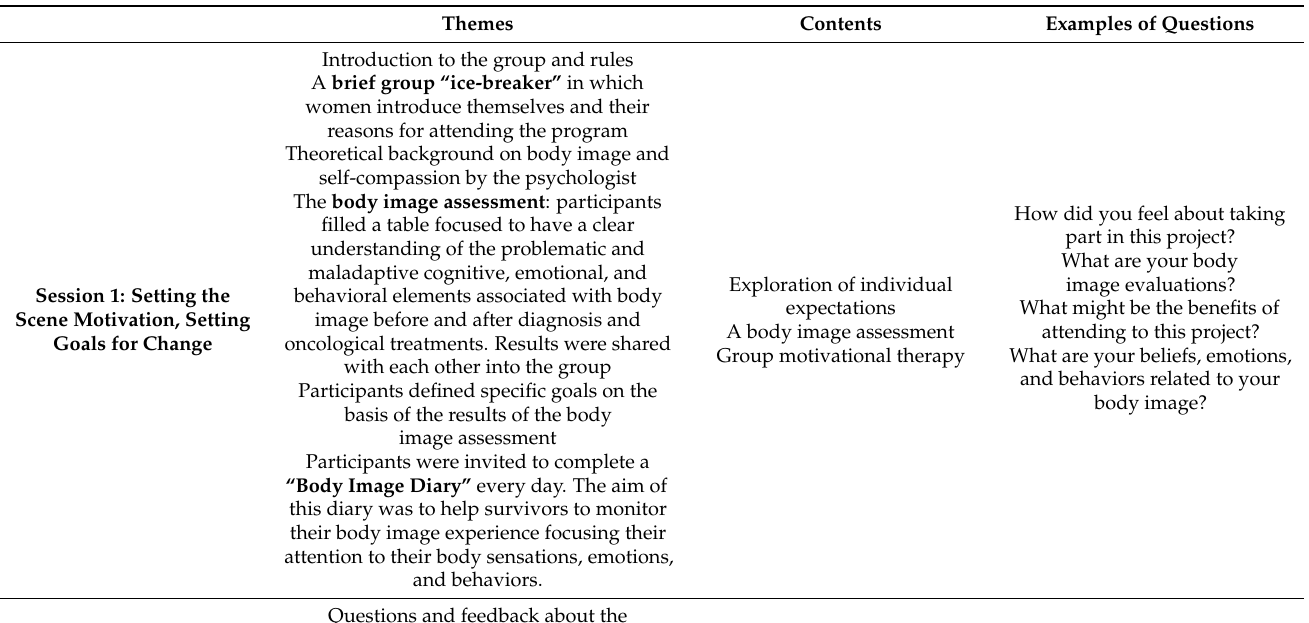
Table 1. Contents of the psychological